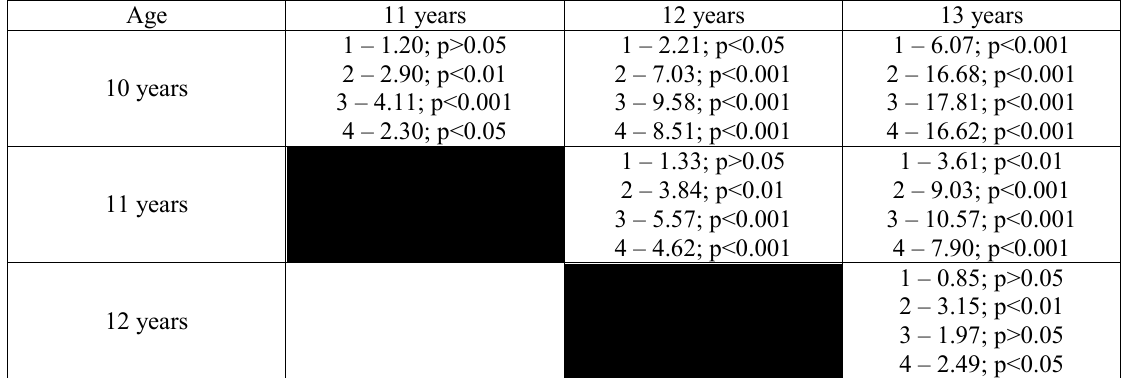
Matrix of indices changes reliability of standing jump of boys aged 10-13 from different groups (n 1 =n 2 =n 3 =n 4